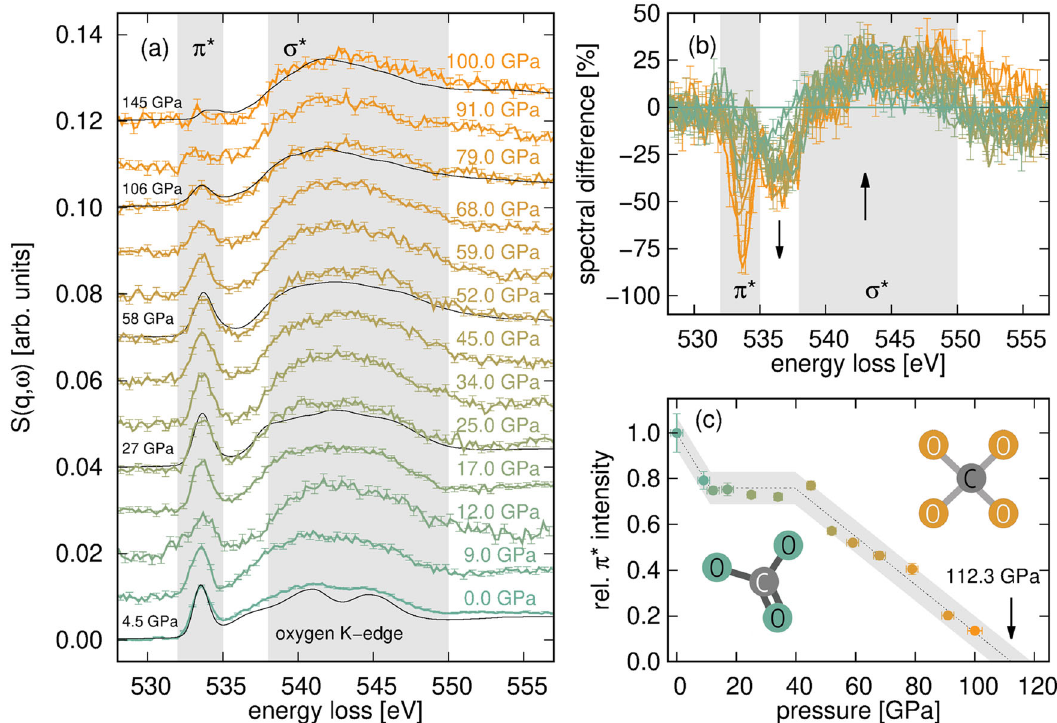
Fig. 1 Experimental and simulated data from XRS spectroscopy. a Oxygen K-edge XRS spectra of K 2 Mg(CO 3 ) 2 glass at pressures between 1 bar and ~100 GPa. Simulated spectra are shown as thin black lines, the values on the left show the pressure at which the simulations were run. The simulated spectra are matched to the most similar experimental spectrum. Error bars present standard errors of the mean, i.e. standard deviation divided by the square root of the sample size. b Spectral differences with respect to the ambient data. The regions of the π *- and σ *- features are marked with shaded gray areas. c Integrated intensity of the π * peak versus pressure. Intensity and pressure error bars represent the standard error given by the peak fi tting